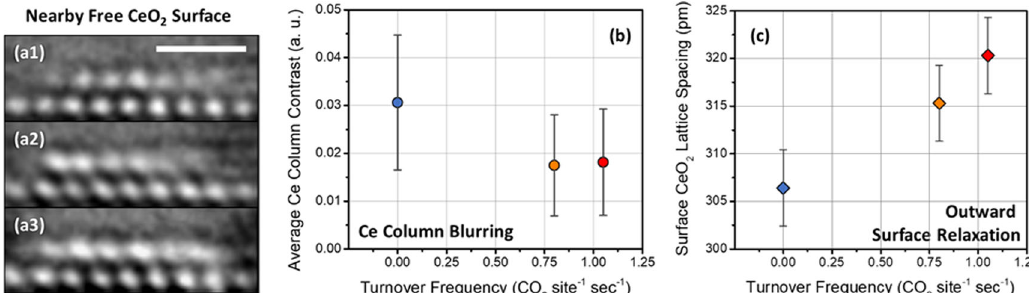
Fig. 6 Quanti fi cation of fl uxional behavior on the free CeO 2 (111) surface near the Pt/CeO 2 interface and correlation with TOF for CO oxidation. a1 – a3 Magni fi ed TEM images extracted from Fig. 4 of the nearby free CeO 2 (111) surface are shown for TOFs of 0.00, 0.80, and 1.05 CO site − 1 sec − 1 , respectively. The scale bar in (a1) corresponds to 1 nm. b The average surface Ce atomic column contrast is plotted against catalytic TOF; error bars are given as the standard deviation relative to the mean measurement. c The separation distance between the surface and subsurface CeO 2 (111) lattice planes is correlated with catalytic TOF, revealing an outward surface relaxation that grows larger with increasing activity. Error bars are derived from the standard deviation about the mean lattice spacing measured in the subsurface and bulk CeO 2